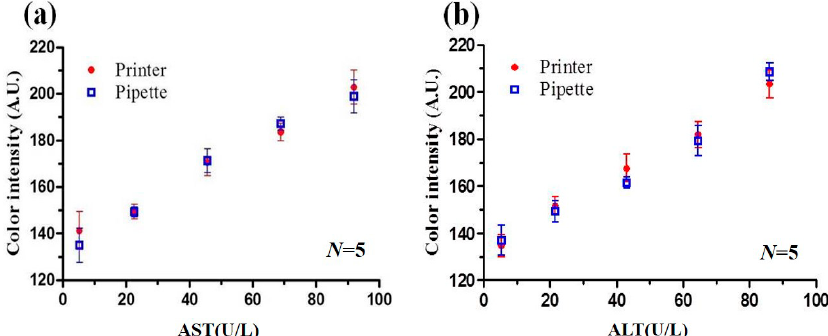
Figure 5. ( a ) Comparison of AST detection results obtained using printer and pipette reagent application methods; ( b ) Comparison of ALT detection results obtained using printer and pipette reagent application methods.